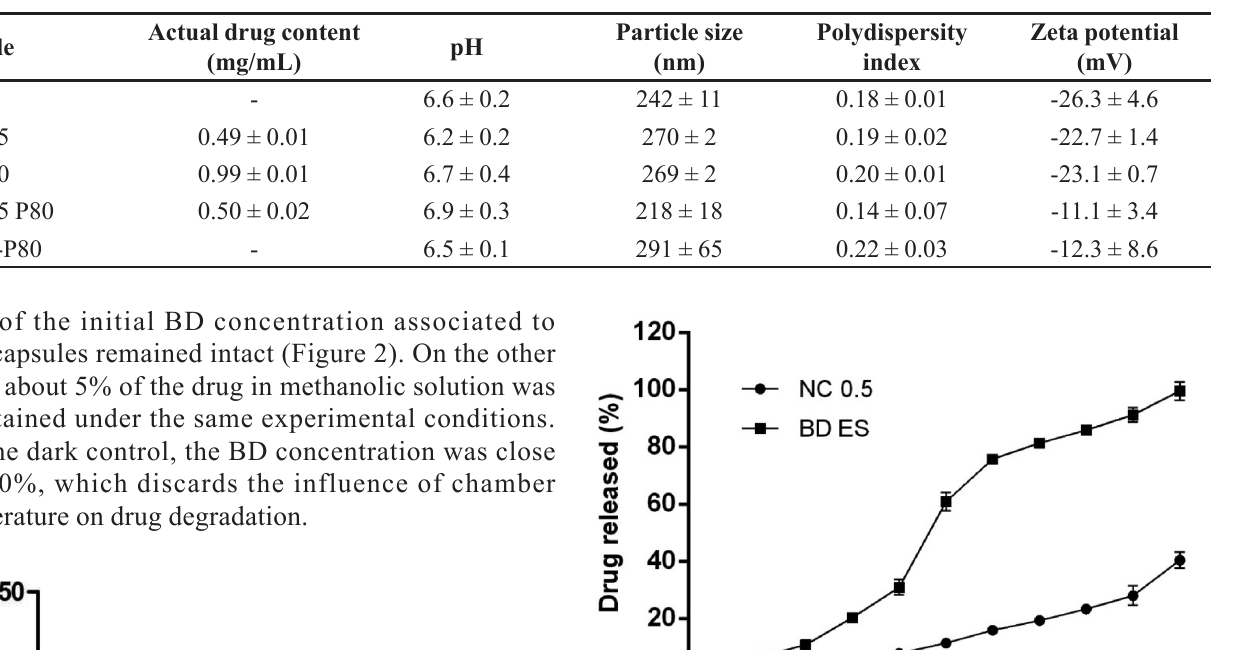
TABLE II - Nanocapsules physicochemical characteristics